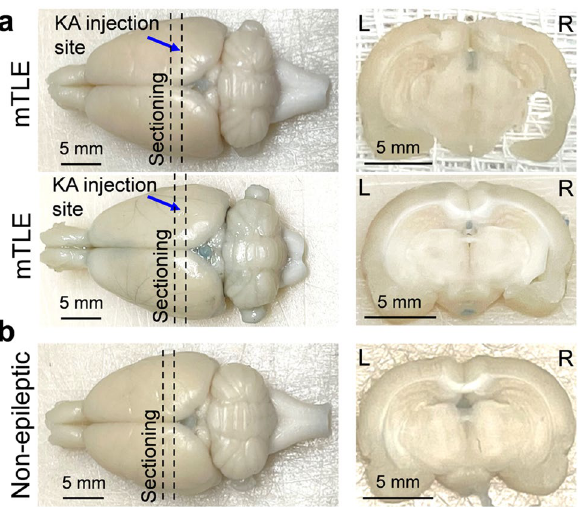
Figure 7. Assessment of post-FUS BBB integrity. Tail vein injection of trypan blue immediately after PHT + / FUS + treatments revealed no signs of BBB disruption in brain specimens from ( a ) two mTLE rats and ( b ) a non- epileptic rat. The blue arrow indicates the location of KA injection site and dotted lines illustrate the sectioning locations. L left, R right.